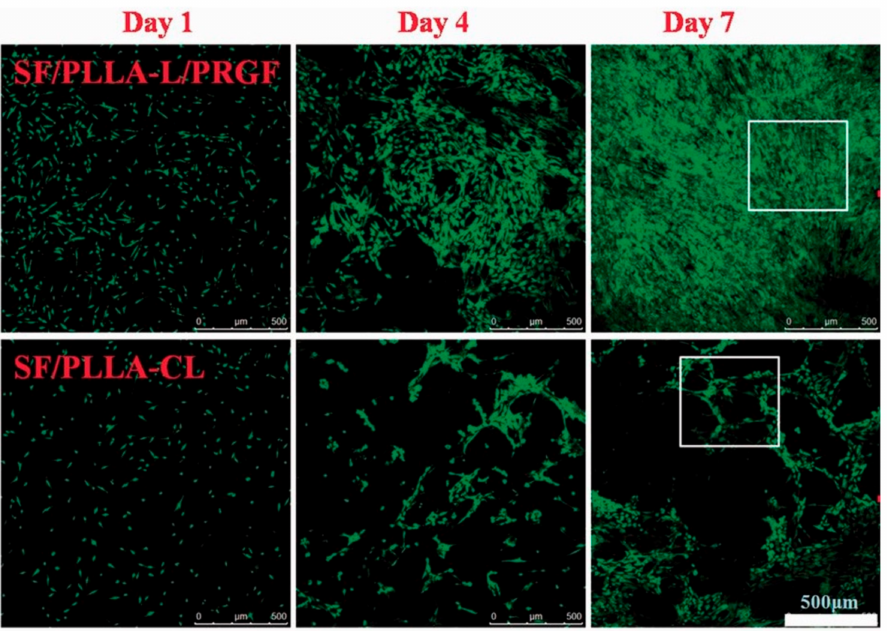
Figure 4. Confocal laser images of SMCs grown on SF/PLLA-CL/PRGF and SF/PLLA-CL for 1, 4, and 7 days. Reprinted with permission from Oxford Academic